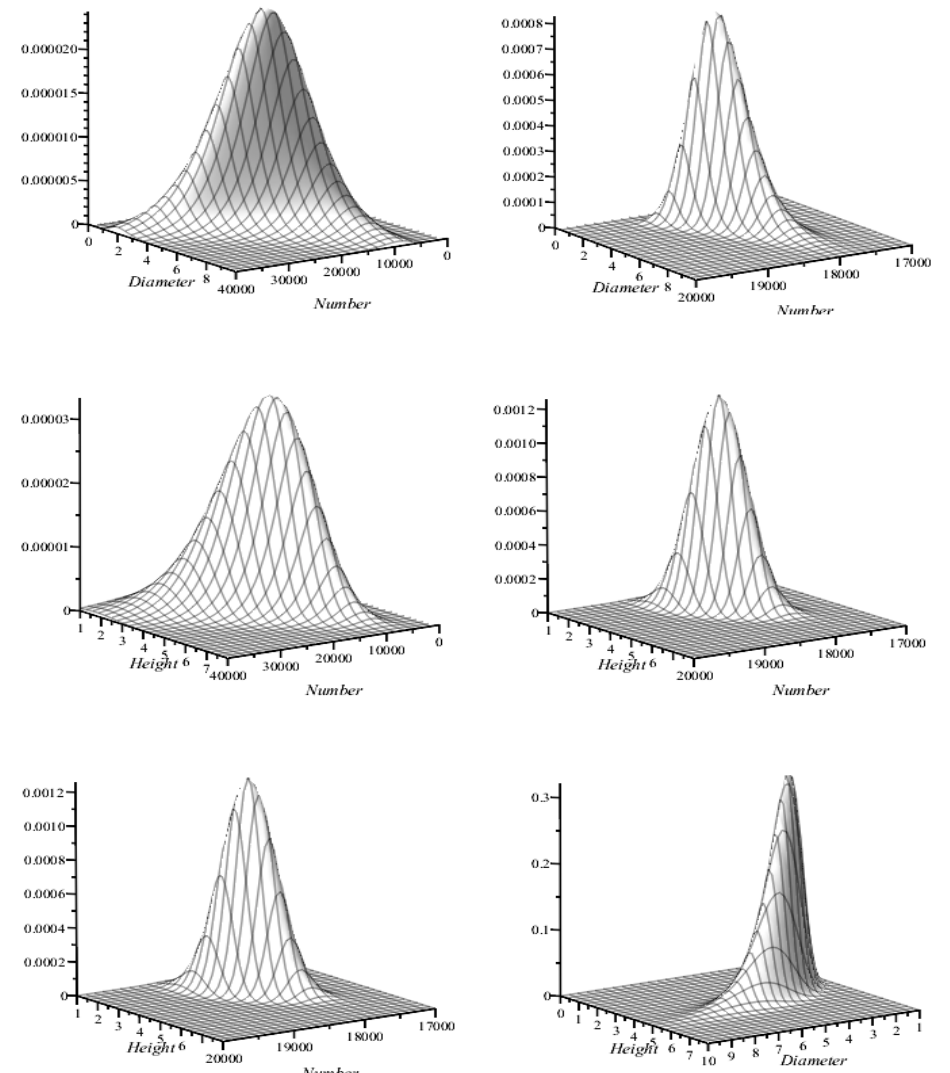
Figure 1. Estimated marginal bivariate probability density functions for a randomly selected stand from a validation dataset (average stand age = 88 years), and both ( Left ) fixed-effects scenario and ( Right ) mixed-effects scenario.